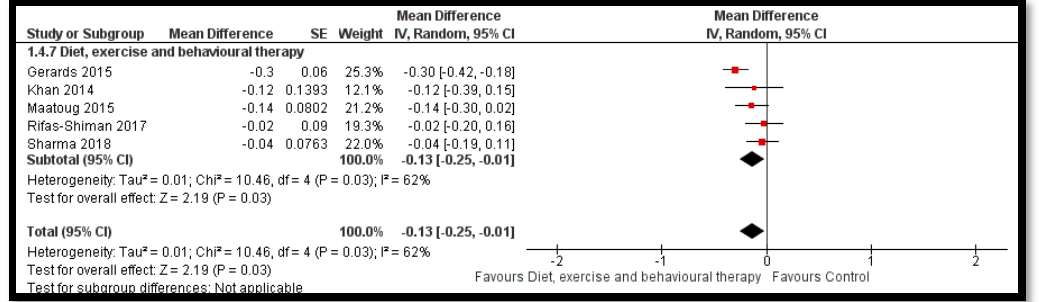
Figure 7. Forest plot for the effect of combined diet, exercise and behavioral therapy interventions for obesity prevention on body mass index (BMI) z -score .